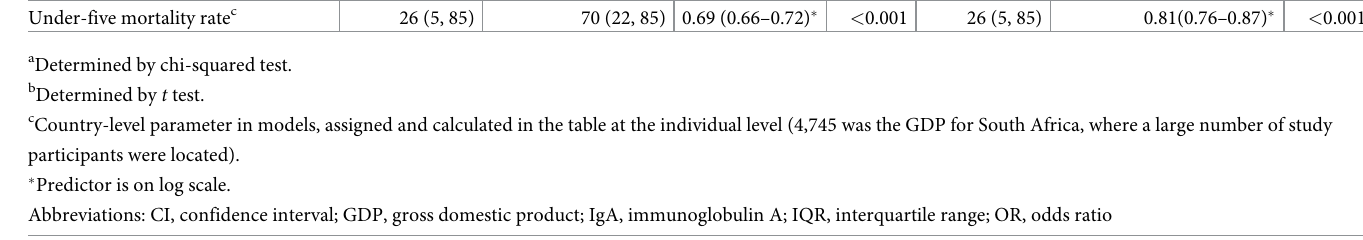
Determined by t test. c Country-level parameter in models, assigned and calculated in the table at the individual level (4,745 was the GDP for South Africa, where a large number of study participants were located). � Predictor is on log